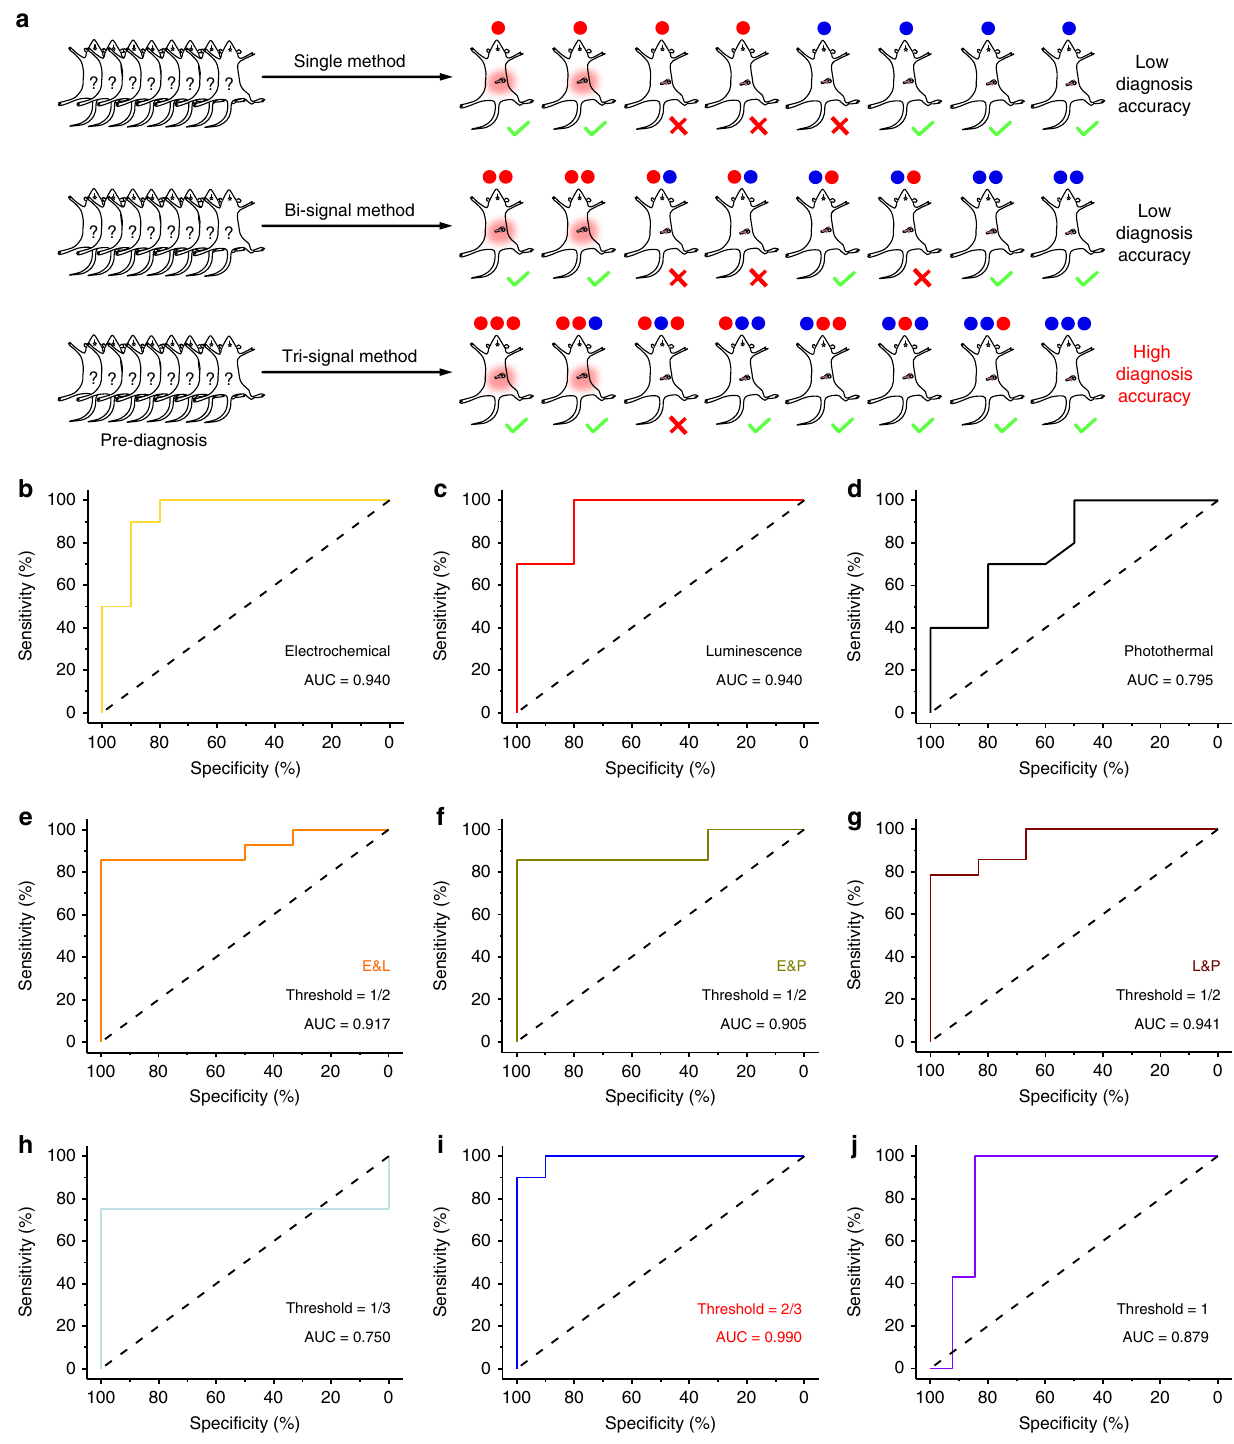
Fig. 4 Improving precision serodiagnosis by three-channel platform. a Schematic illustrations of AP serodiagnosis by single-, two-signal and three-signal method based on three-channel platform. Receiver-operating characteristic curve presenting the probability for the assay to correctly distinguish between normal and AP cases based on the plasma C H2S in the blood samples determined by various methods including single-signal method by electrochemical ( b ), luminescence ( c ), and photothermal signal ( d ); two-signal method with joint use of electrochemical and luminescence (e&l, e ), of electrochemical and photothermal (e&p, f ), and of luminescence and photothermal (l&p, g ); three-signal method with threshold of 1/3 ( h ), with threshold of 2/3 ( i ), and with threshold of 1 ( j